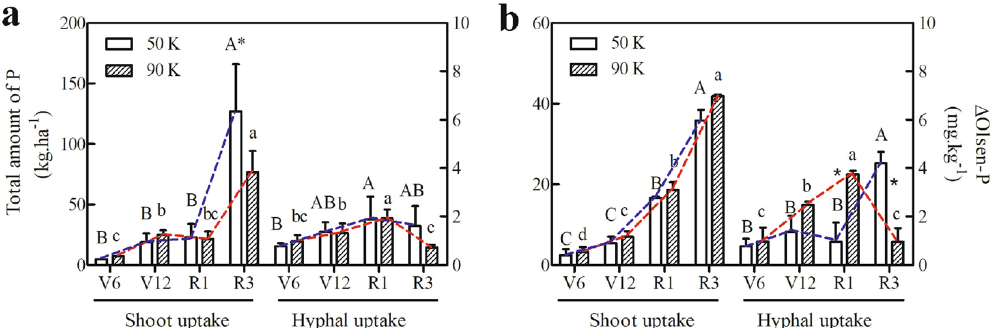
Figure 2. Shoot and hyphal uptake of P ( (cid:31) P) at different growth stages and planting densities in 2013 ( a ) and 2014 ( b ). Error bars represent SD values of the means (n = 6). Different uppercase letters indicate significant differences in P consumption status ( P ≤ 0.05) among growth stages under low planting density; different lowercase letters indicate significant differences in P consumption status ( P ≤ 0.05) among growth stages under high planting density; asterisk indicates significant difference ( P ≤ 0.05) between different planting densities.